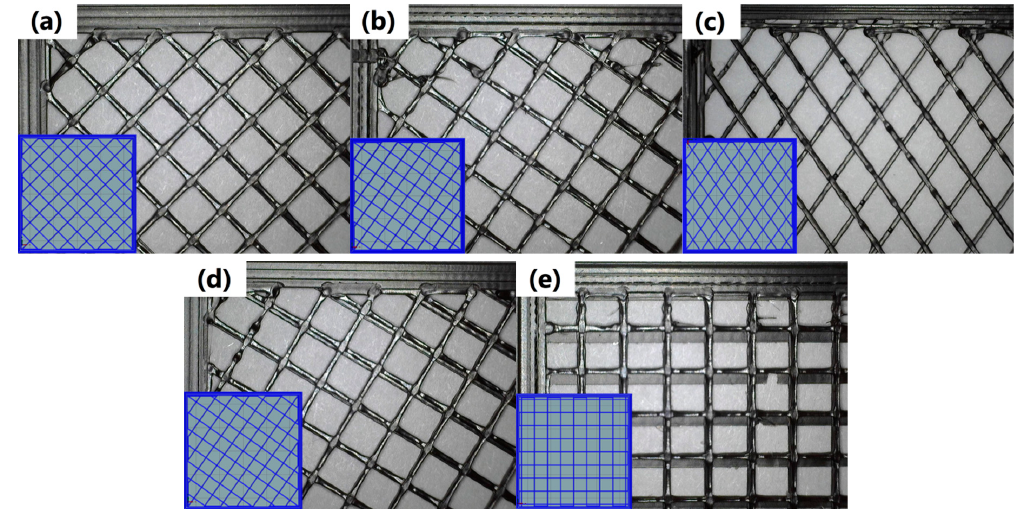
Figure 2. Scheme of layers’ deposition during 3D printing of samples (at 20% infill percentage) for following infill angles: ( a ) 45°, ( b ) 55°, ( c ) 55’°, ( d ) 60° and ( e ) 90°.